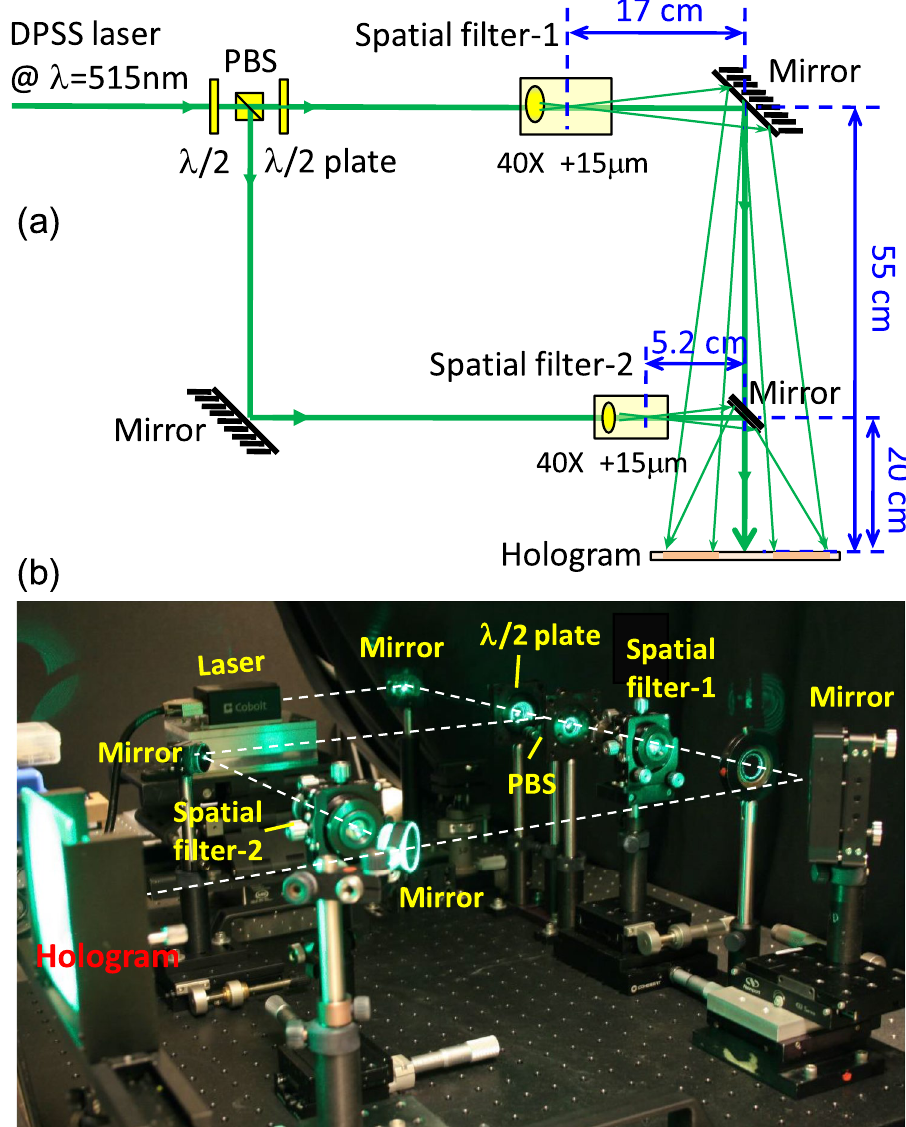
Figure 4. ( a ) A schematic diagram of the optical recording system for Fresnel Hologram. ( b ) A photo of the recording setup using a λ = 515 nm laser. The optical path of light is indicated by white dashed